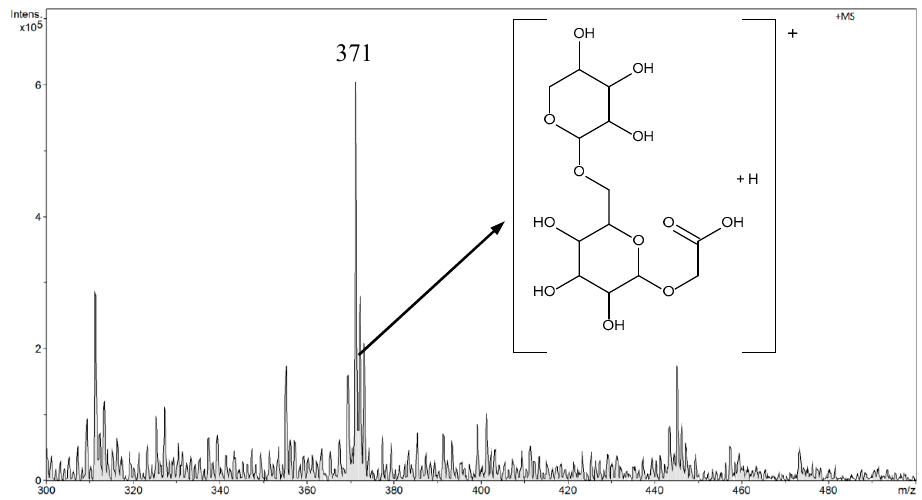
◦ C. Biomolecules 2020 , 10 , x FOR PEER REVIEW